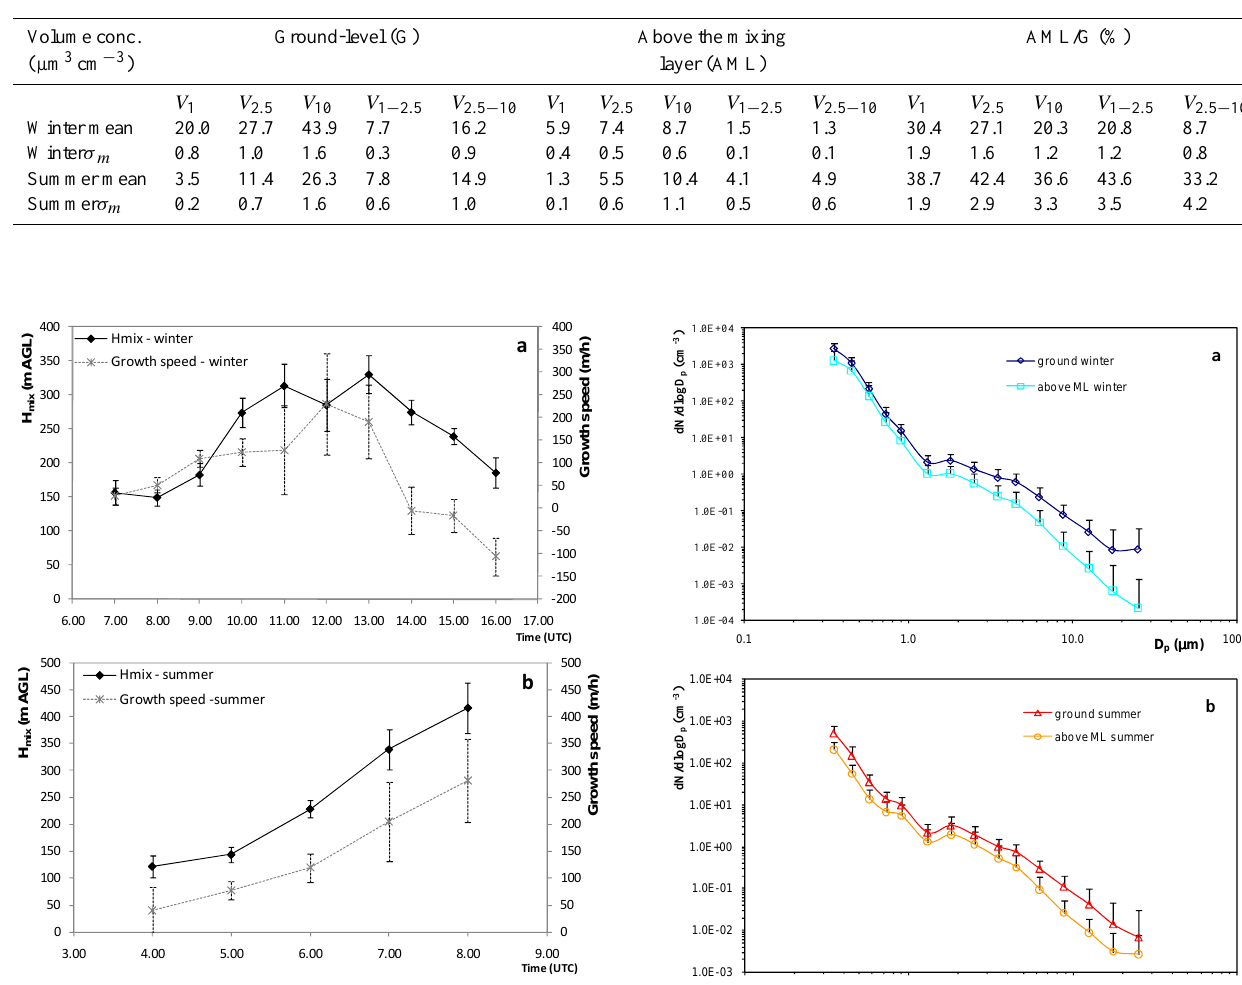
Fig. 4. H mix (m) and H mix growth speed (m/h) hourly averaged values for: (a) winter (DJF months; N profiles=142), (b) summer (JJA months; N profiles=72).